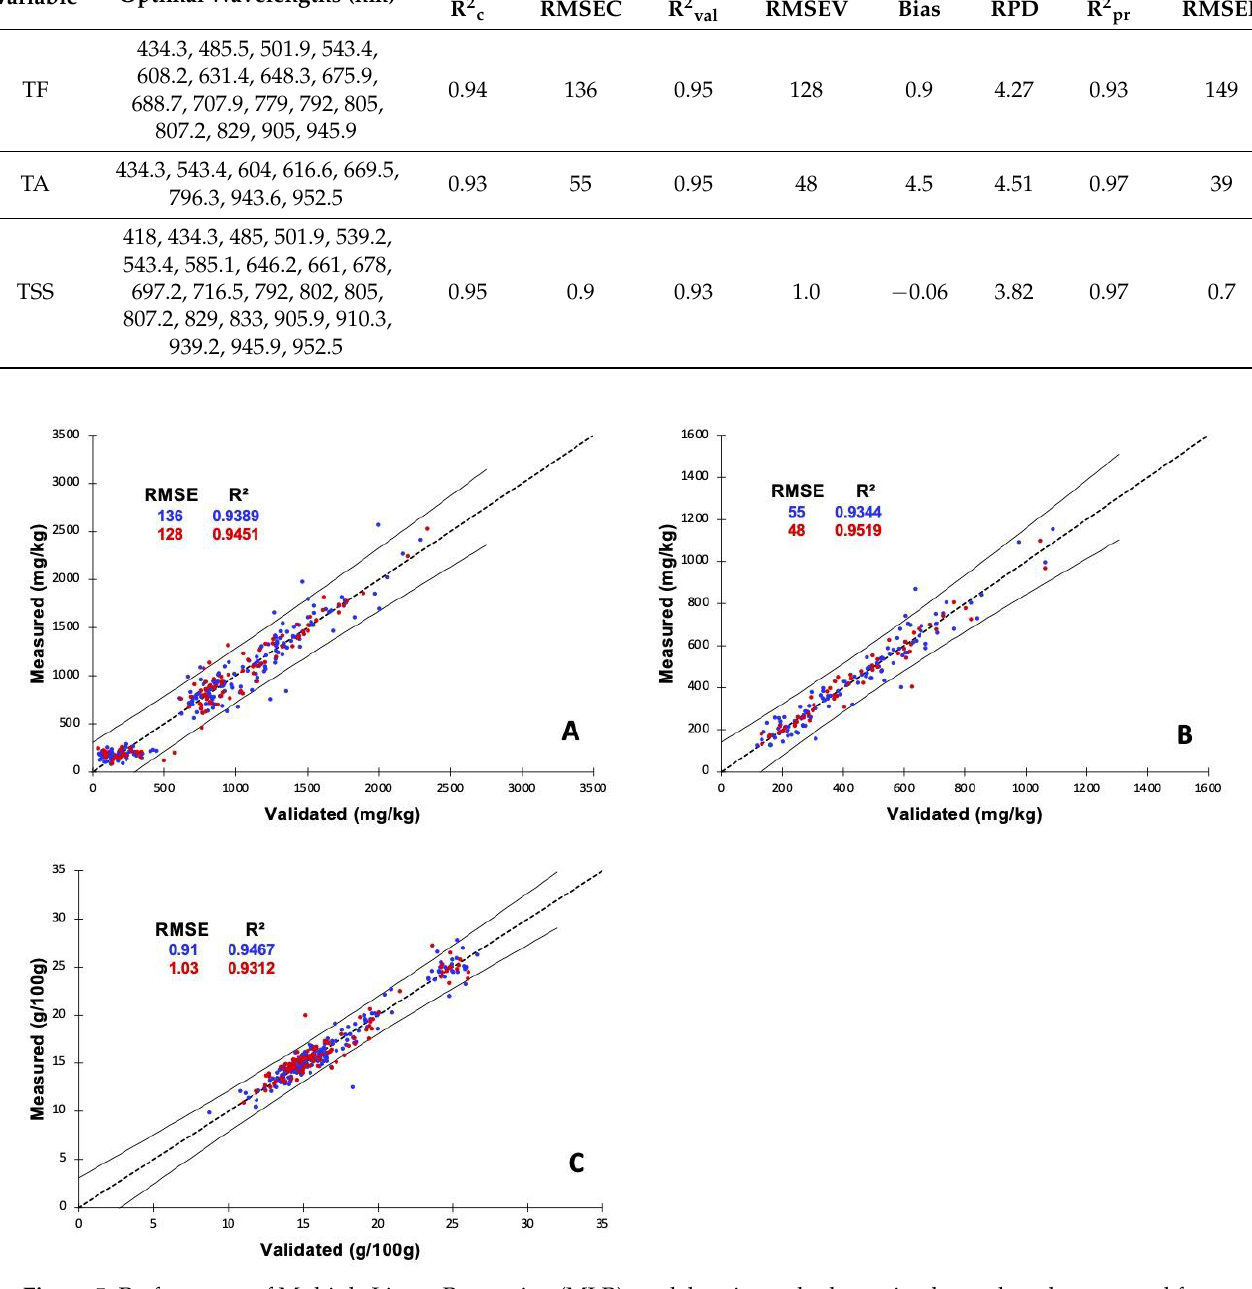
Figure 5. Performance of Multiple Linear Regression (MLR) models using only the optimal wavelengths extracted from β -coefficients of PLS analysis. Calibration and external validation using SNV pre-treated data: ( A ) for Total Flavonoids, ( B ) for Total Anthocyanins, and ( C ) for TSS. Blue dots indicate calibration set and black dots represent validation set.